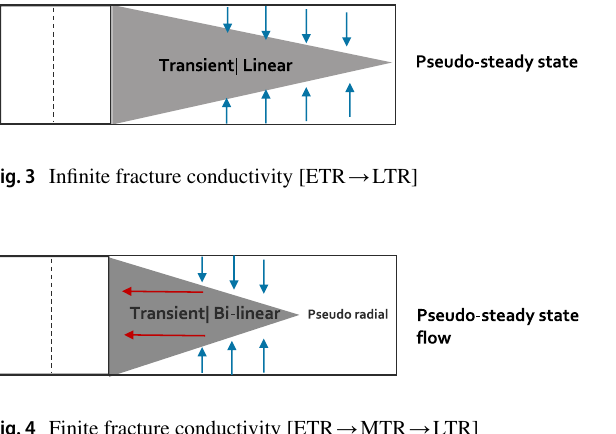
Fig. 4 Finite fracture conductivity [ETR → MTR →